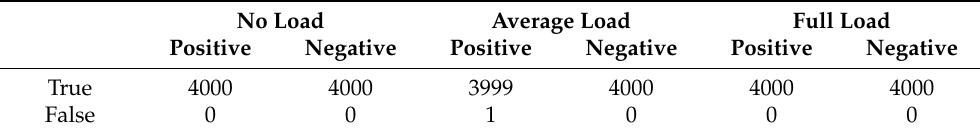
Table 9. Detection results under different load